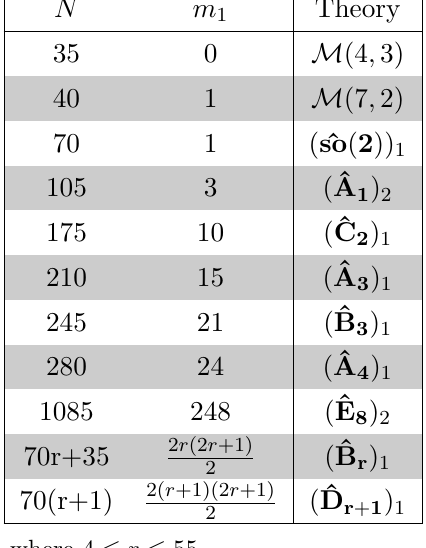
Table 5 . Category I : irreducible.